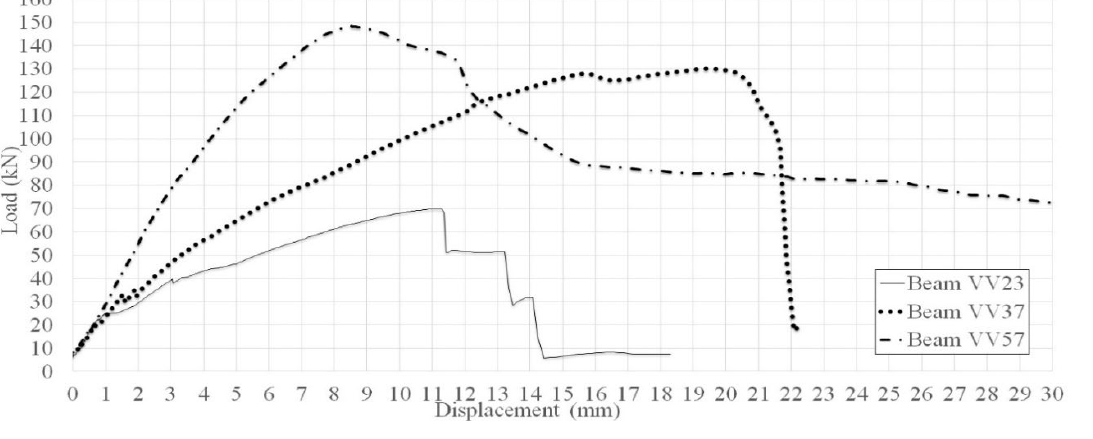
Figure 14. Load vs displacement curves - Beams reinforced with